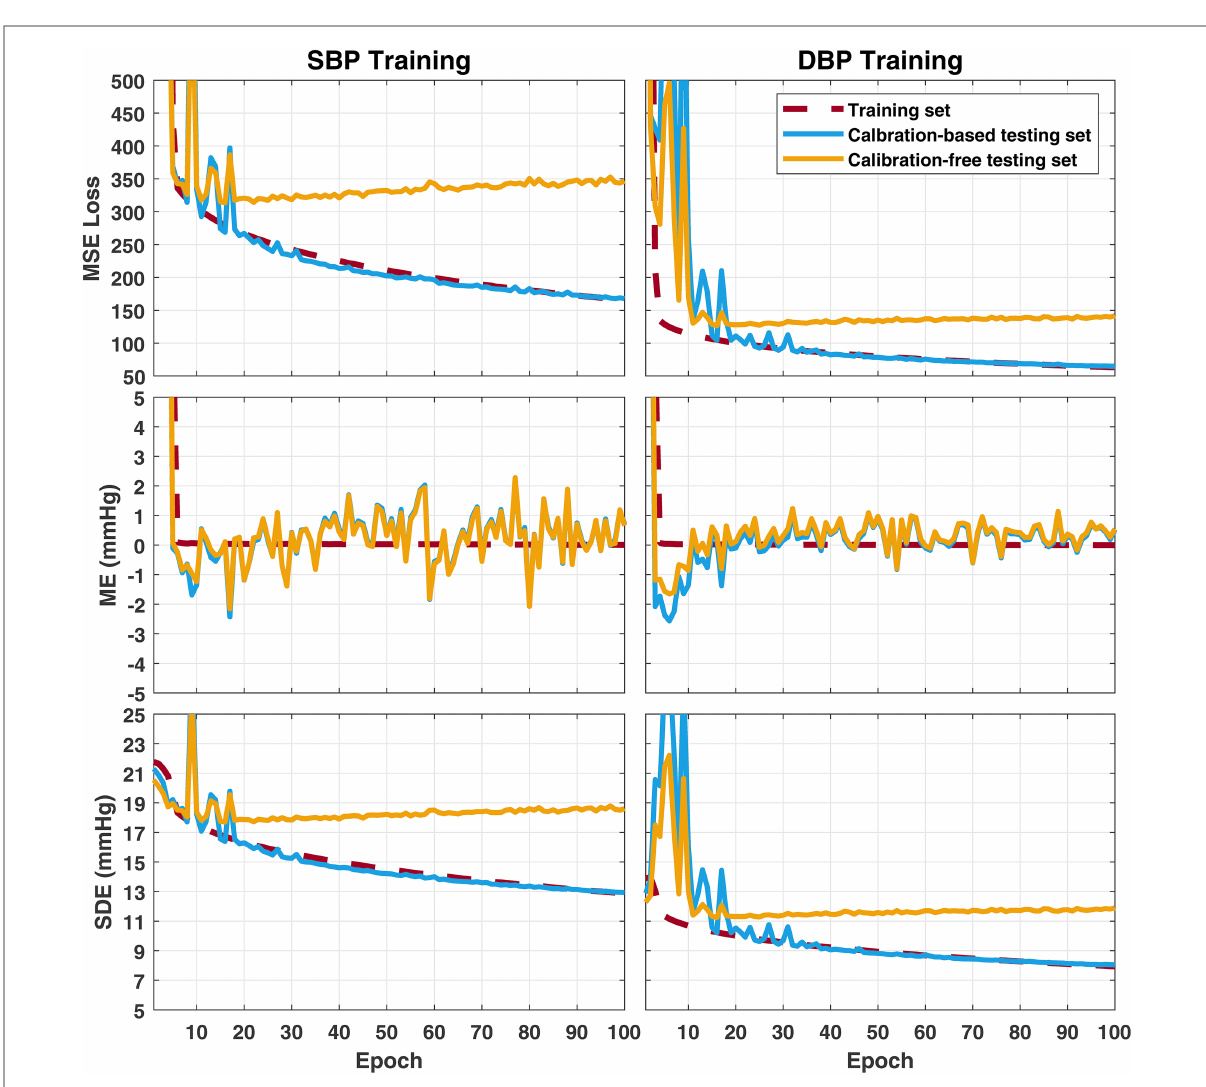
FIGURE 5 Change of error metrics on the training set, the calibration-based testing set, and the calibration-free testing set, when training the 1D ResNet-18 to estimate SBP (left) or DBP (right). MSE, mean squared error; ME, mean error; SDE, standard deviation of